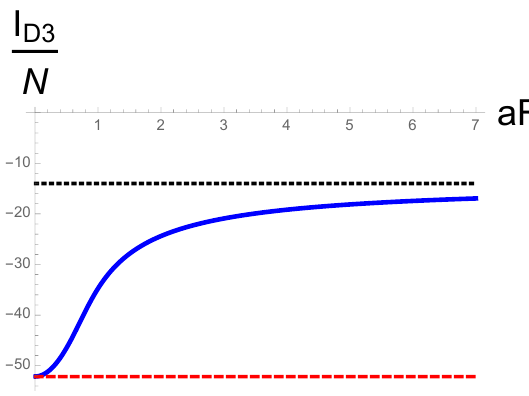
Figure 5 . The free energy (cid:0) ln Z H = I D3 (2 (cid:25) ) of the D3-brane impurity in hyperbolic space with (cid:12) = 2 (cid:25) and ~ (cid:20) = 7 : 0 increases towards the IR as the deformation ( aR ) is increased. In the UV it matches the symmetric Wilson loop (dashed red line) and asymptotes in the IR towards k times the circular Wilson loop in the fundamental